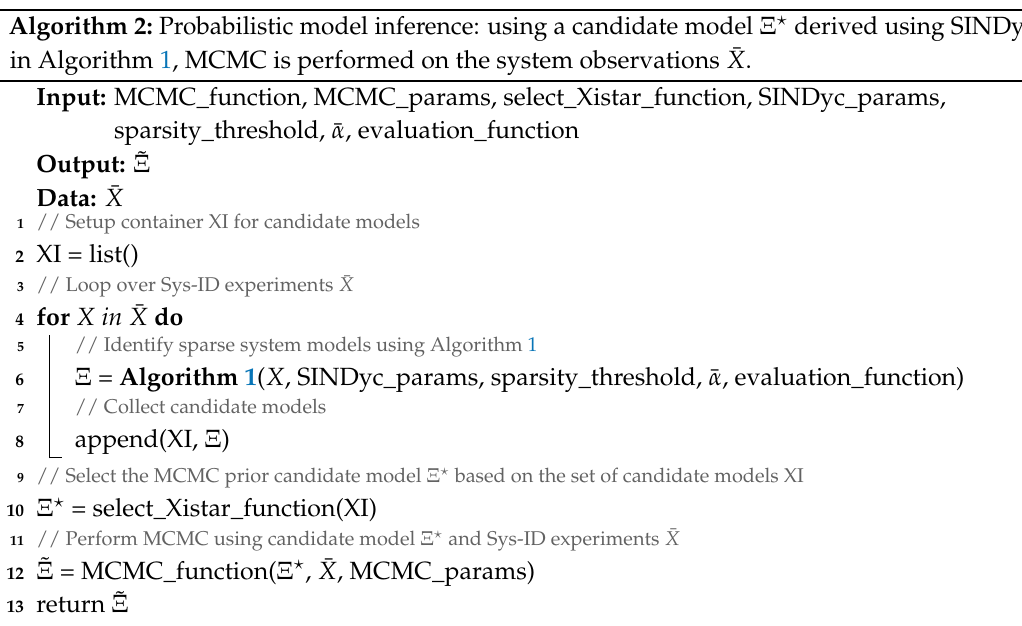
Algorithm 2: Probabilistic model inference: using a candidate model Ξ (cid:63) derived using SINDyc in Algorithm 1, MCMC is performed on the system observations ¯ X